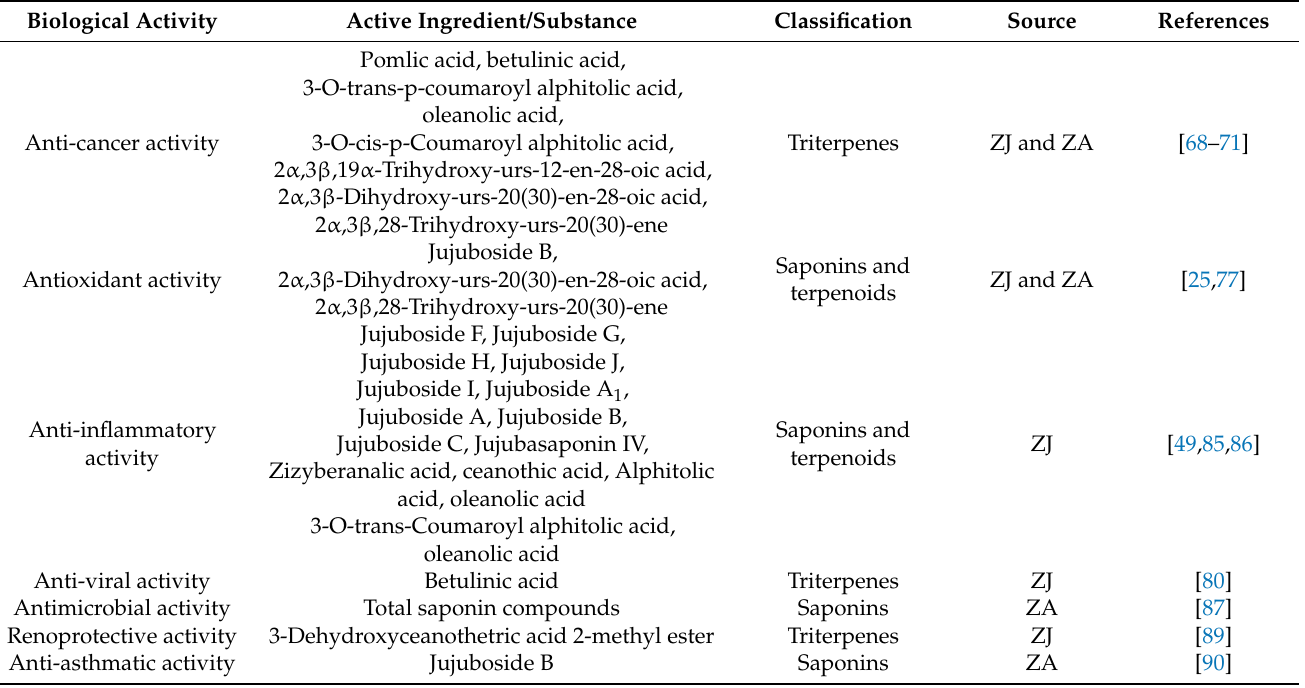
Table 3. Biological activities of triterpenoids from ZJ and